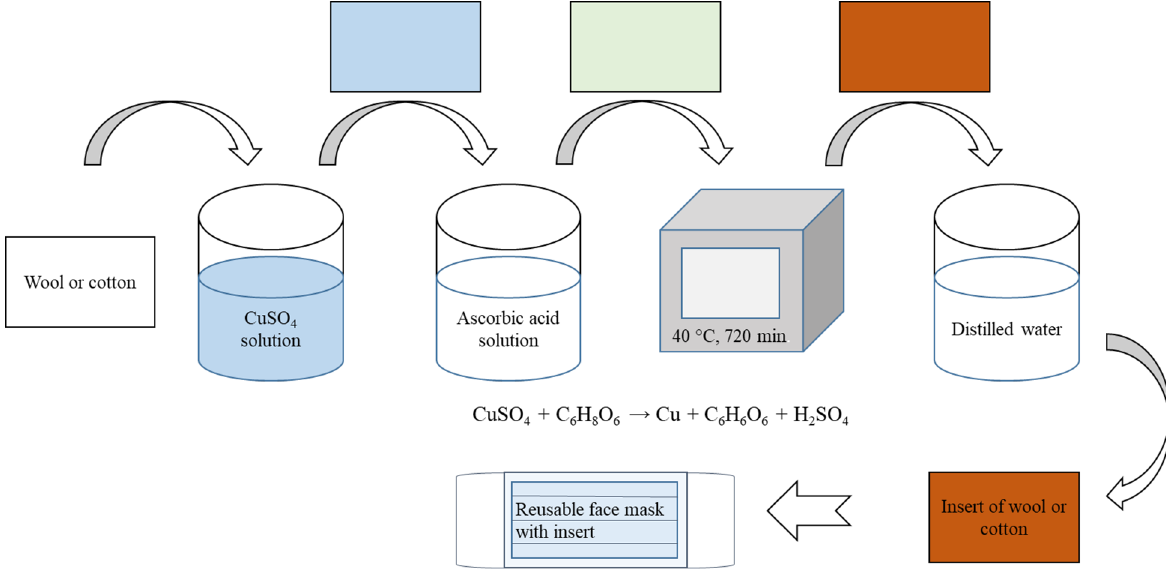
Figure 1. Schematic diagram of the synthesis of copper particles and the preparation of inserts for reusable face masks.